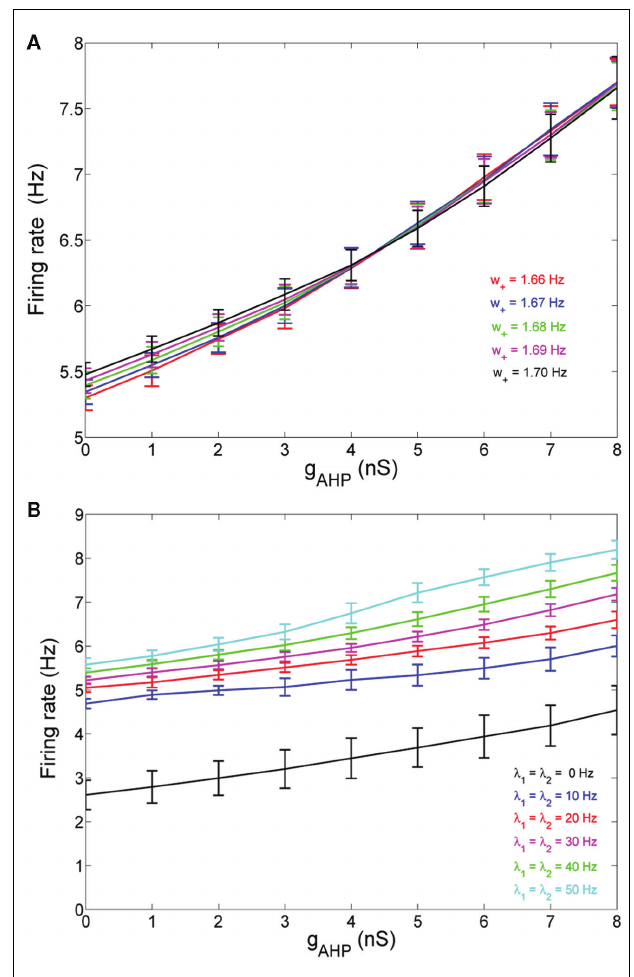
FIGURE 2 | (A) Average firing rate of the non-selective neuronal population as a function of the level of adaptation at different recurrent connectivities for external input λ 1 = λ 2 = 40Hz. (B) Average firing rate of the non-selective neuronal population as a function of the level of neuronal adaptation at different external stimuli for recurrent connectivity w + =